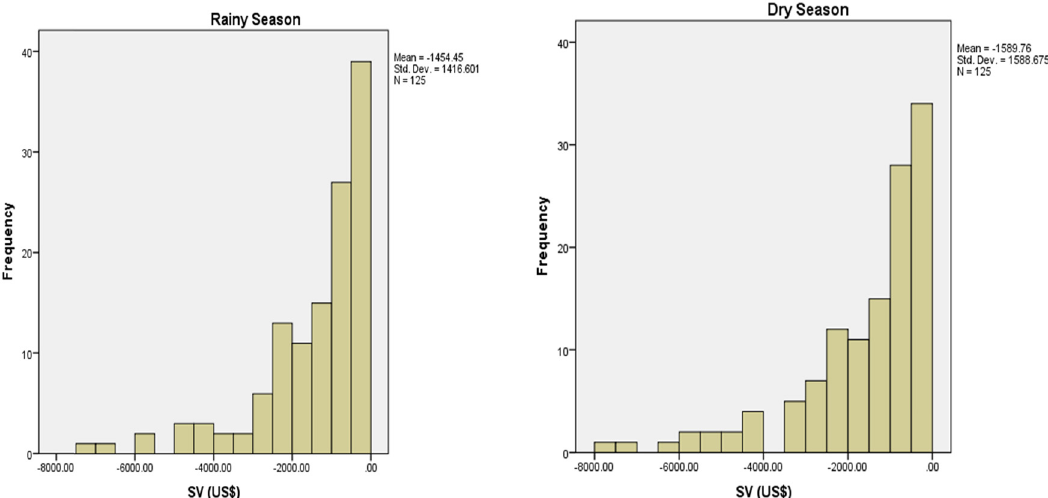
Figure 2: Histogram showing SV for all observations of rainy and dry season rice farming.